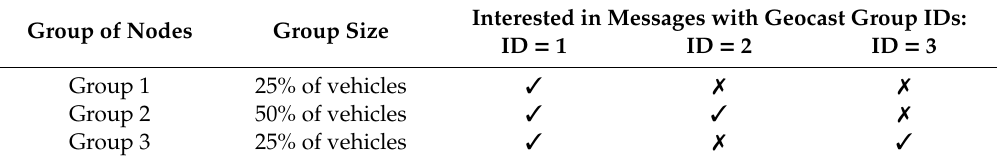
Table 3. Groups of vehicles interested in the distinct geocast services for the Helsinki scenario.